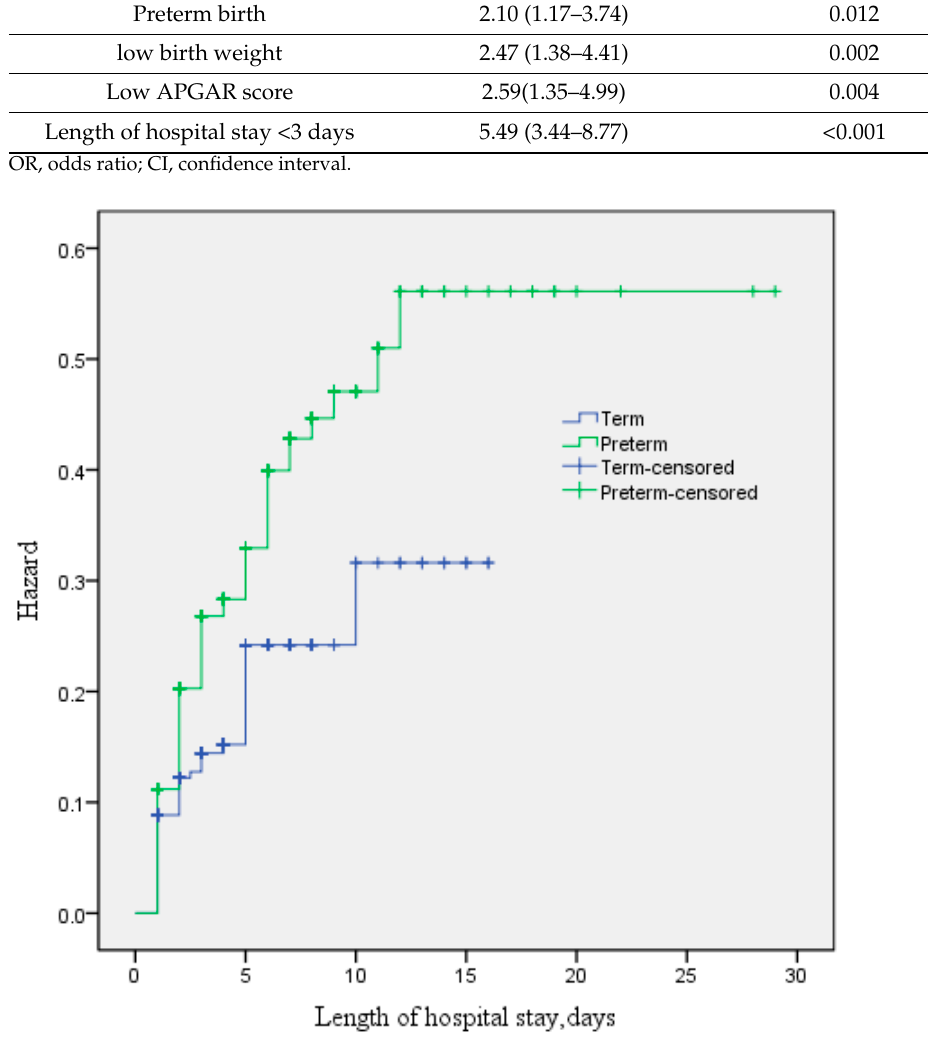
Figure 2. Kaplan–Meier curve to show the difference between preterm and full-term